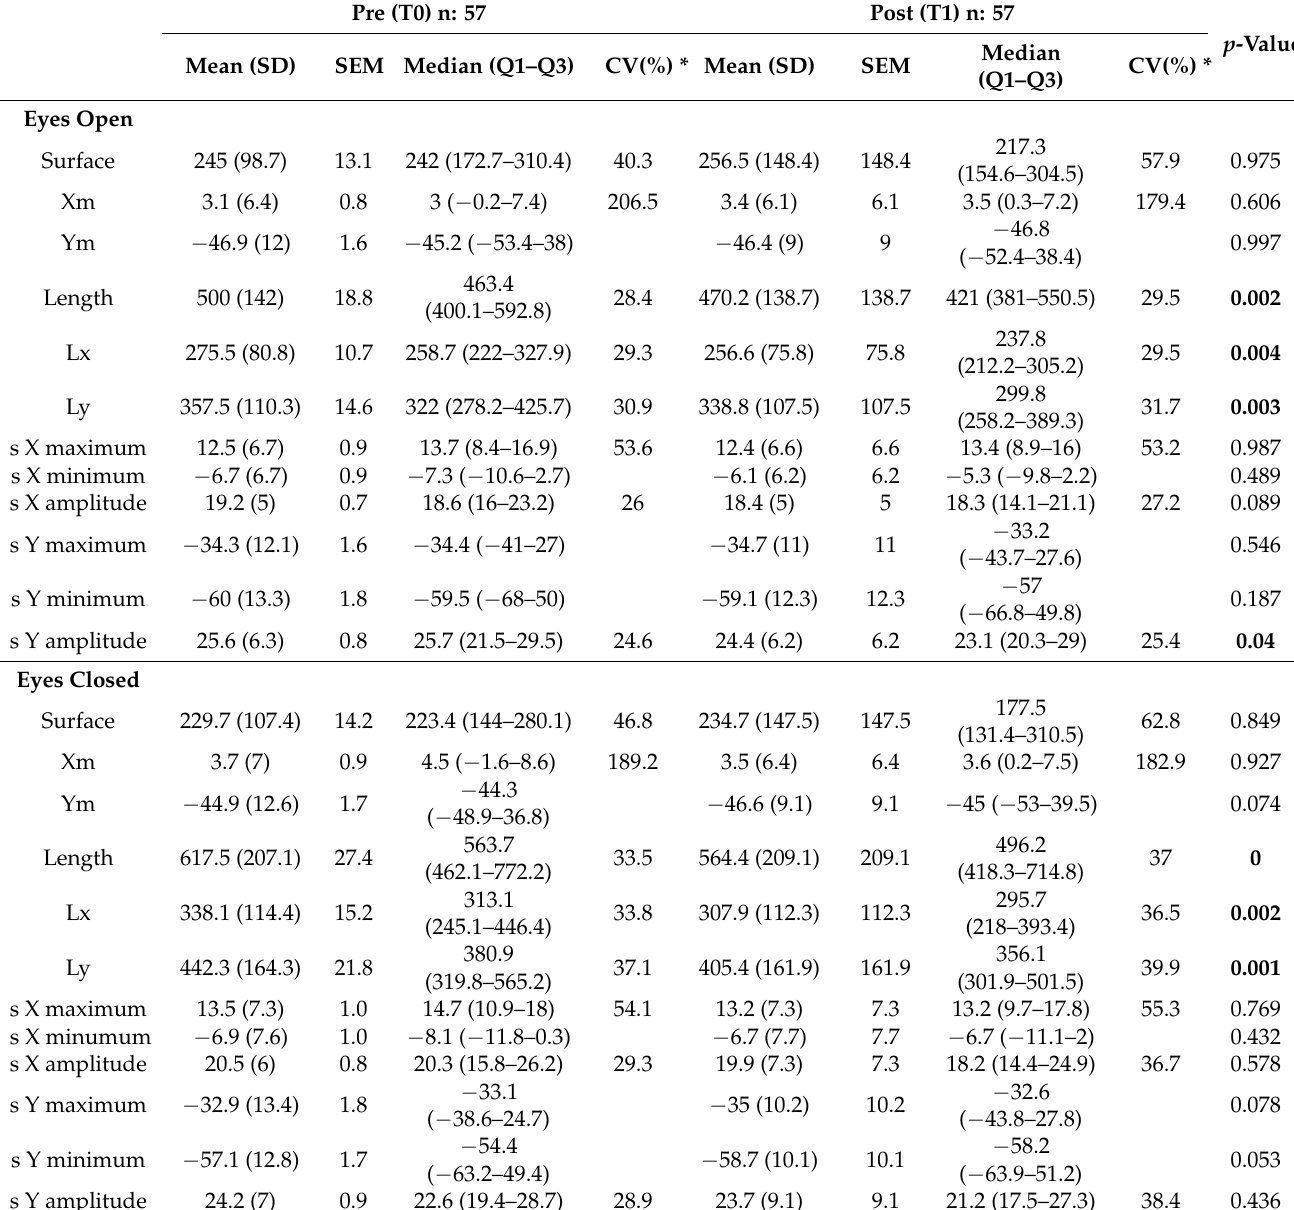
Table 2. Comparison between pre-post intervention with eyes open and